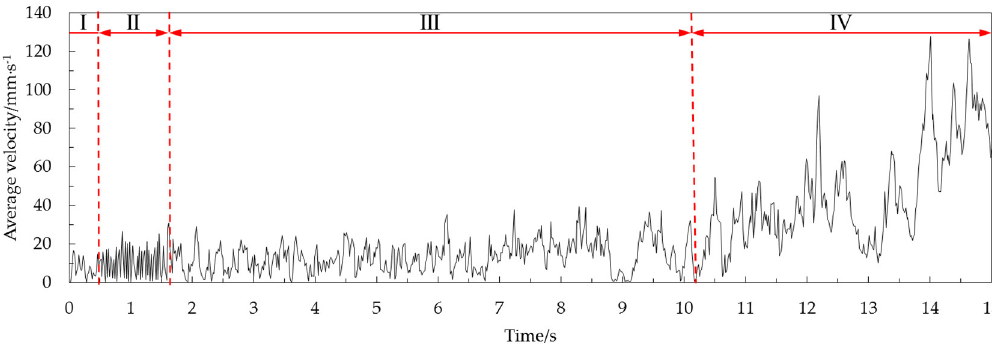
Figure 11. Average velocity of the corn grain in the area below 20 mm on the free surface at a half cone angle of 45°.